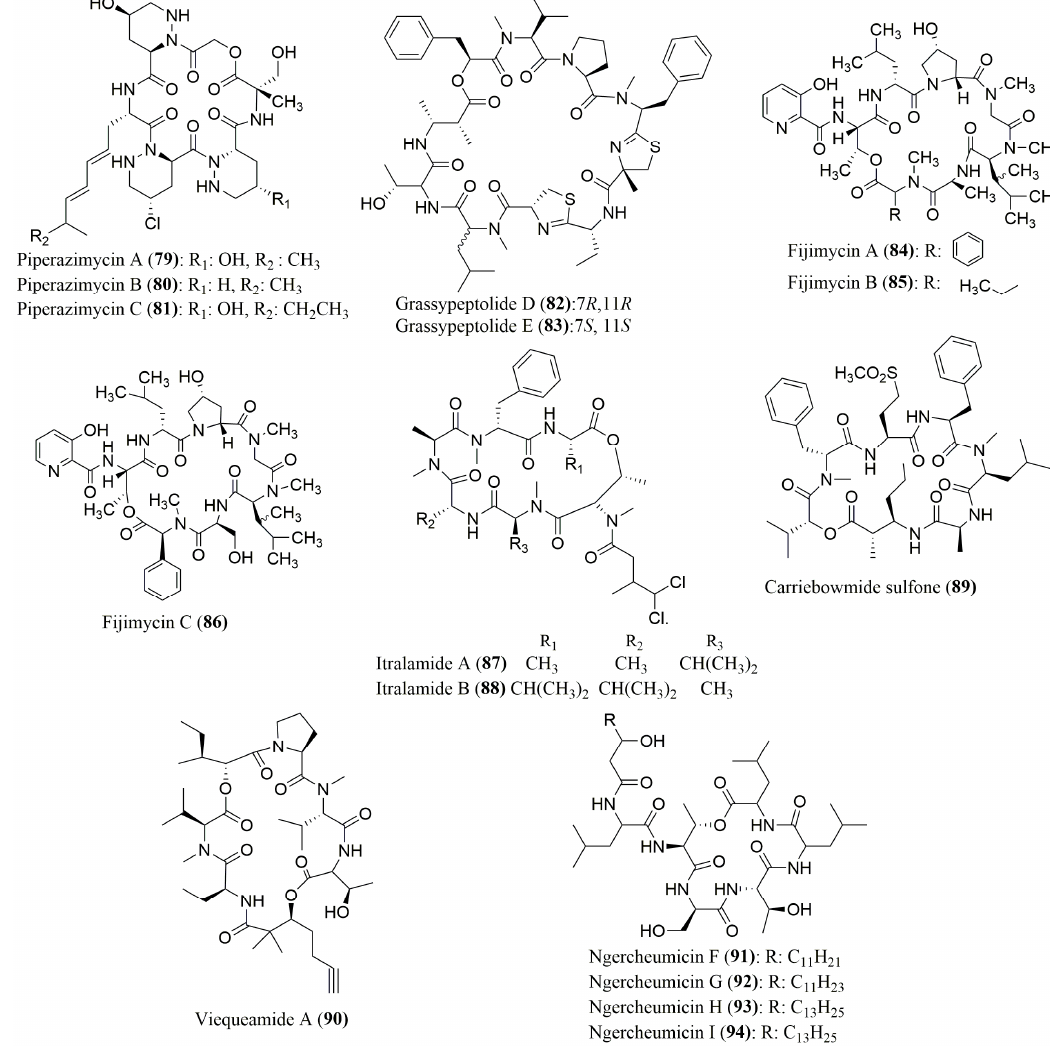
Figure 6. Structure of cyclic depsipeptides 79 – 94 , isolated from marine cyanobacteria and other bacteria, whose stereochemistry of their amino acids was determined by Marfey’s method.